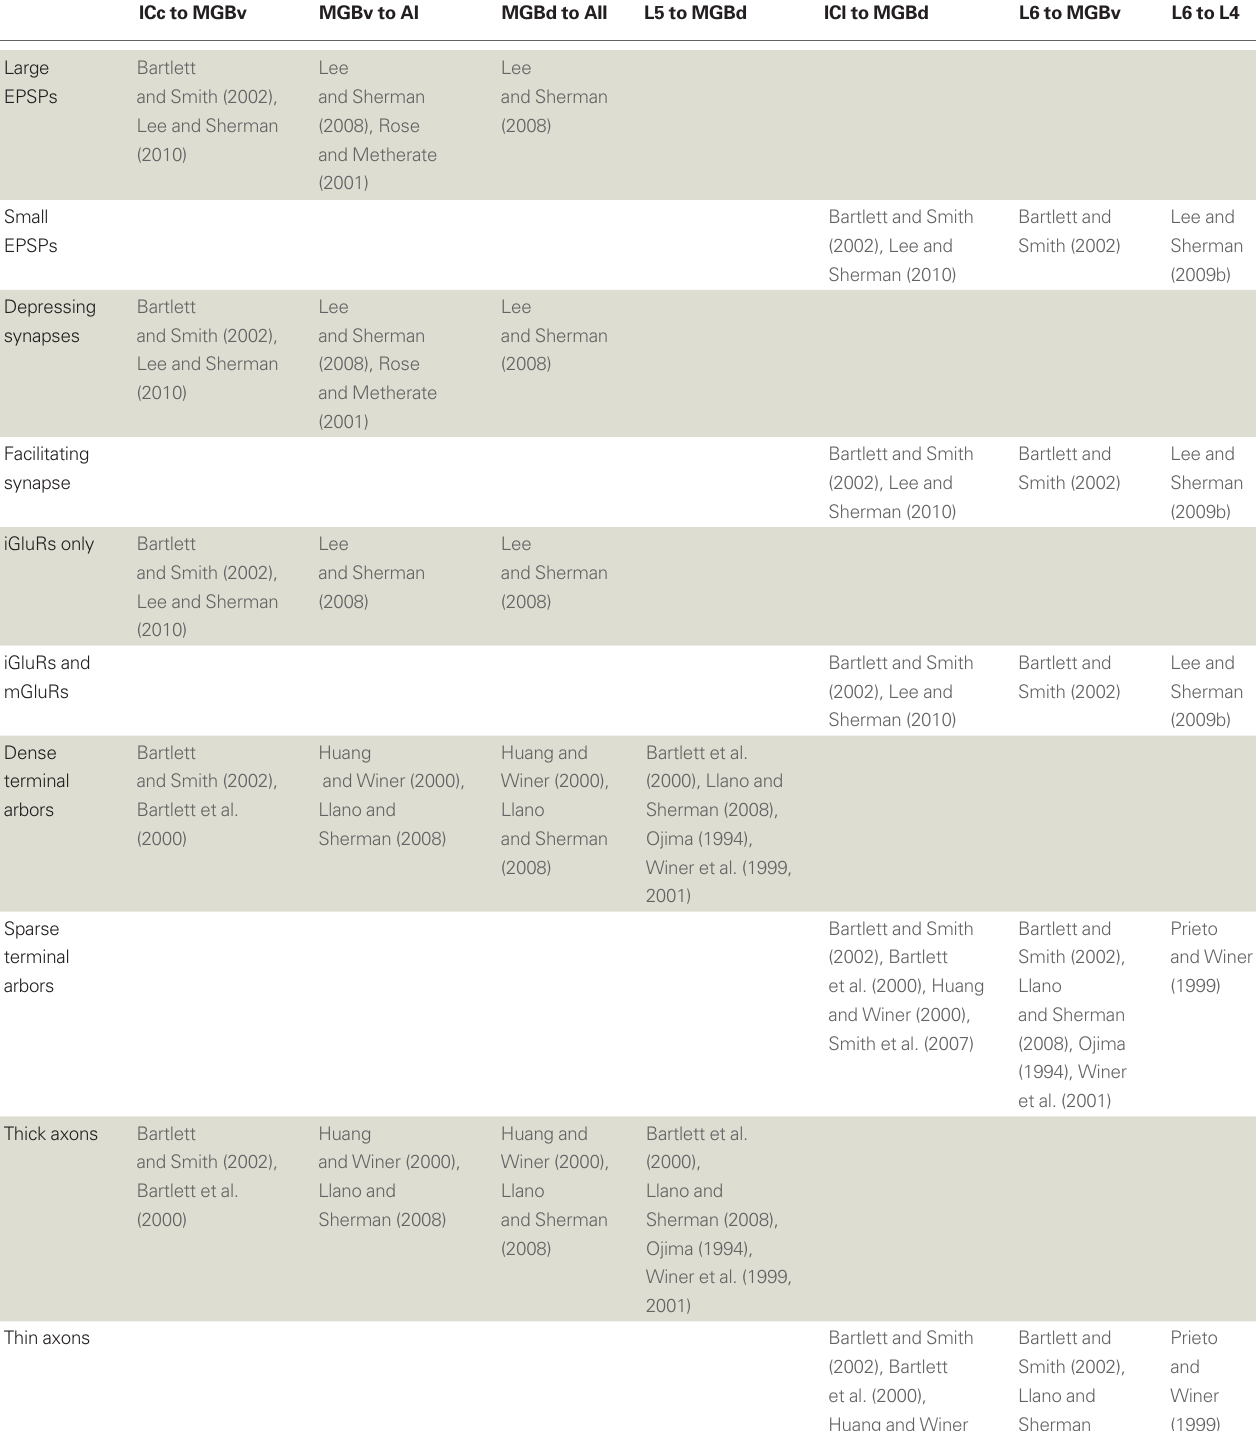
Table 1 | Driver and modulator properties of the central auditory